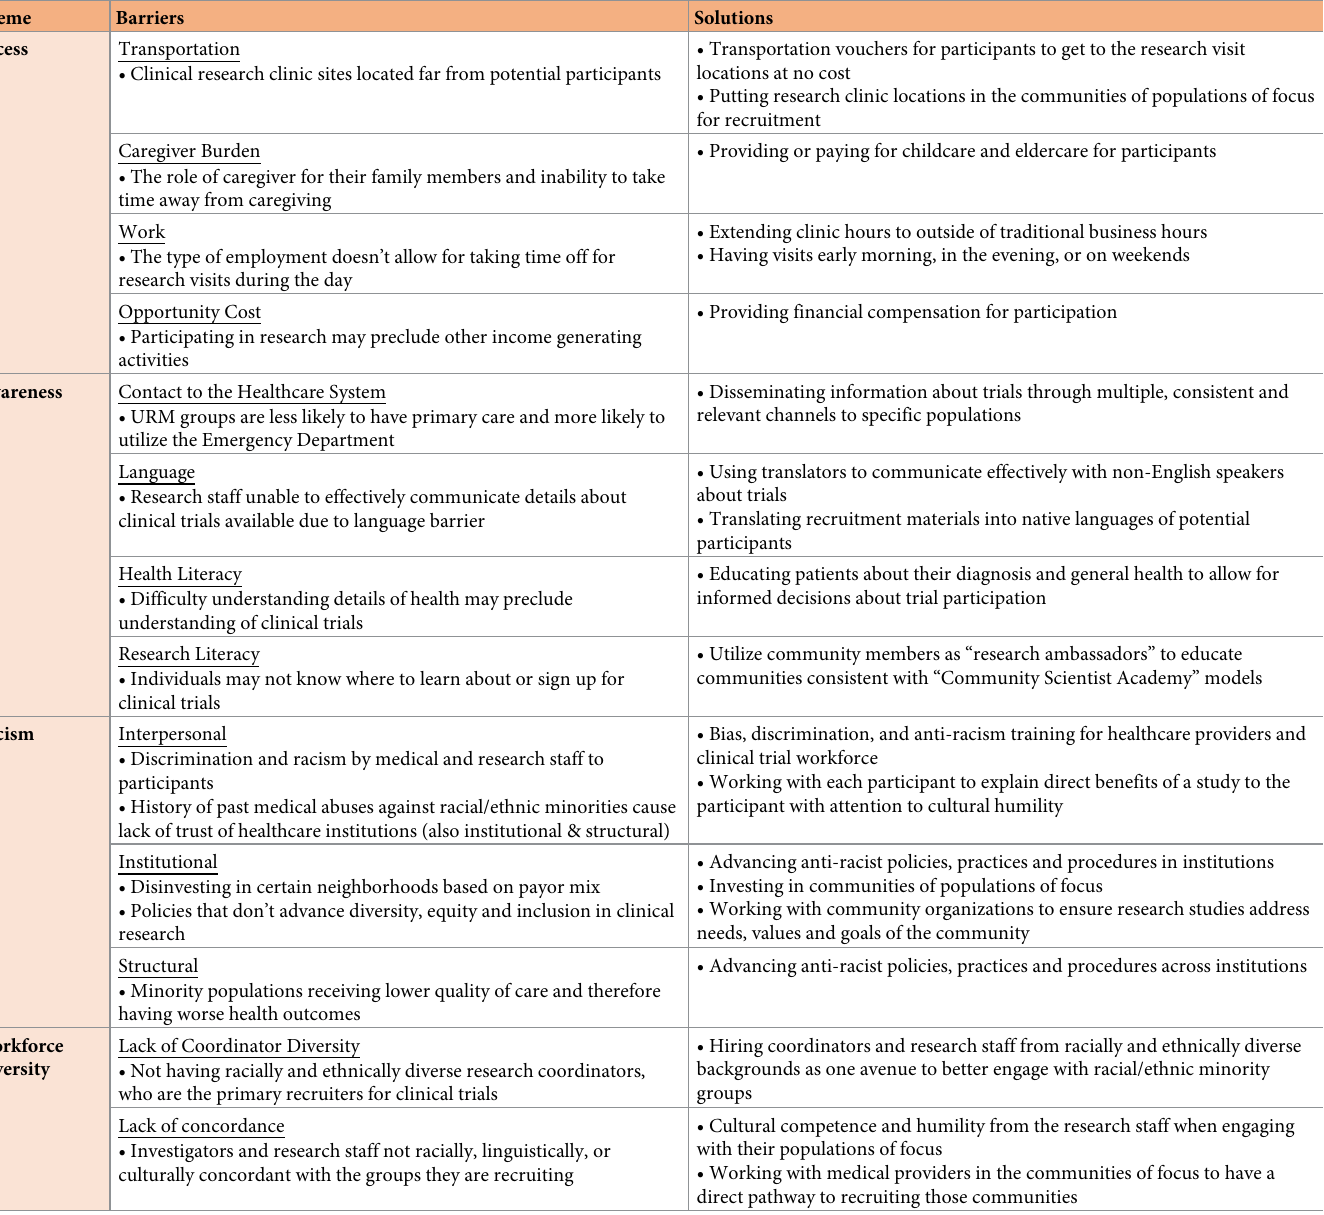
Table 6. Barriers and solutions to clinical trial